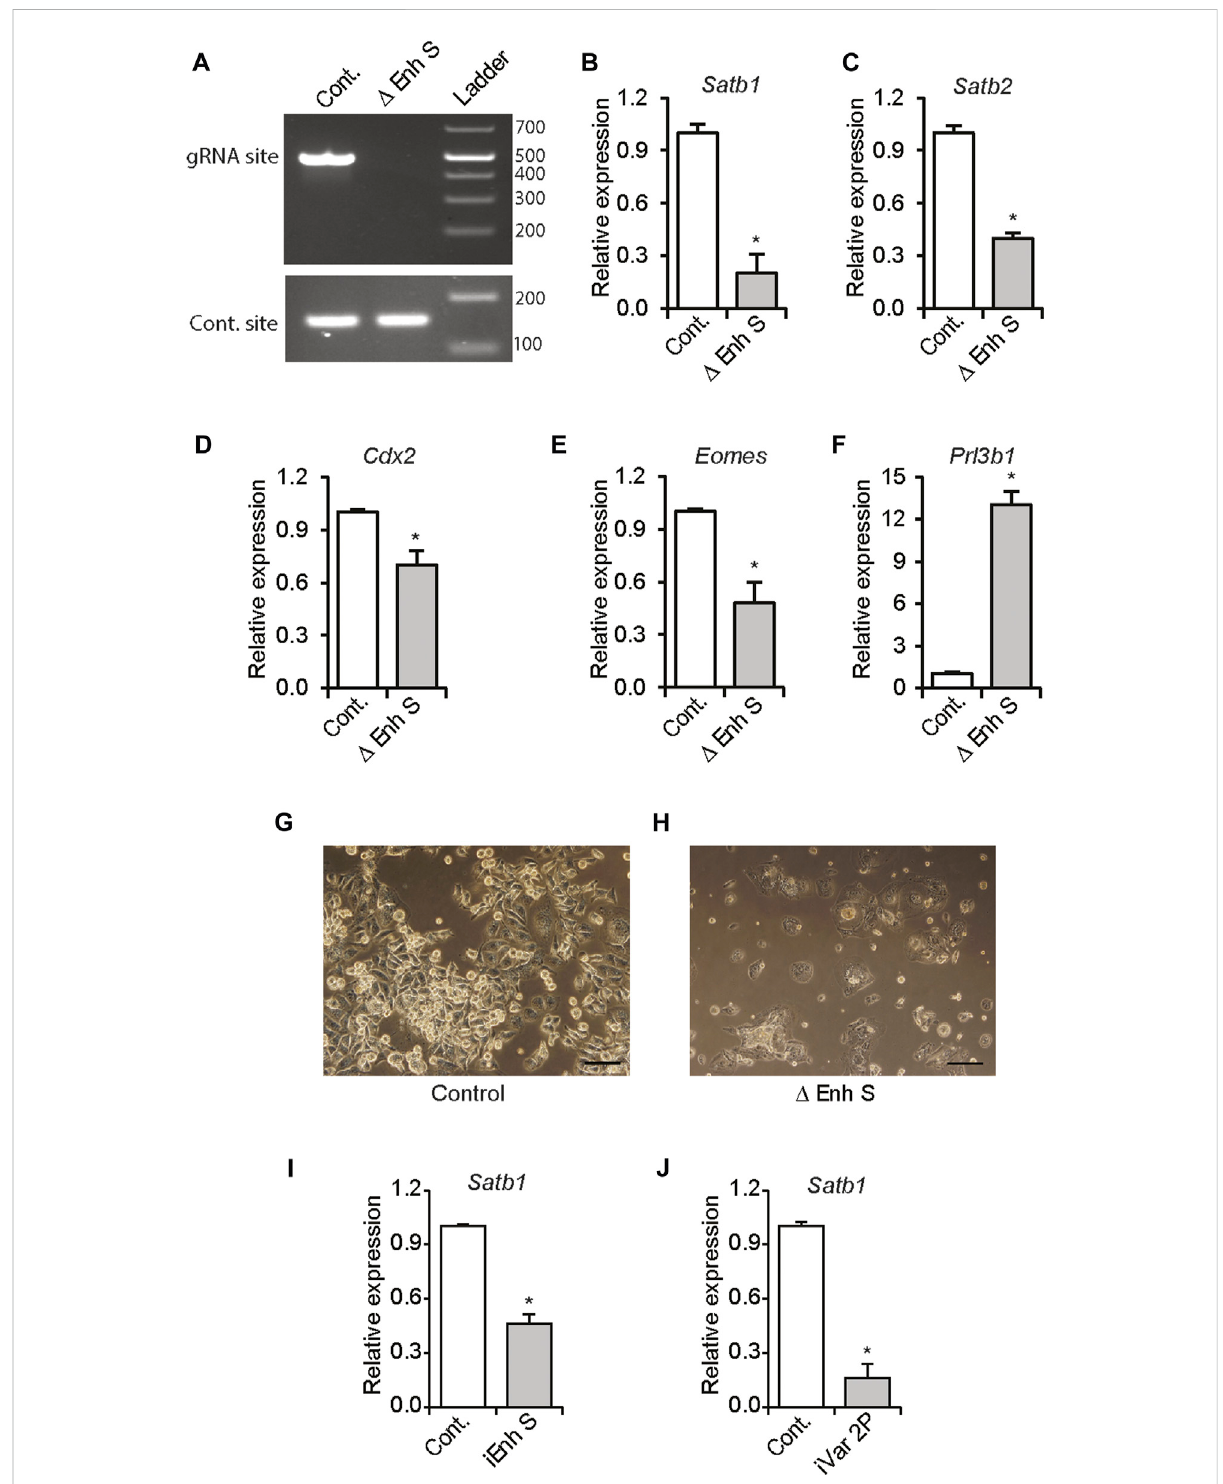
FIGURE 4 Enhancer S is required for Satb1 expression. Rcho1 rat trophoblast cells were transfected with Cas9 and control or targeted gRNA expression constructs. Stably transfected cells were selected and assessed for targeted deletion of the enhancer. Applying the CRISPR/Cas9 system resulted in the deletion of the gRNA targeted site in enhancer S ( Δ Enh S) (A) , decreased Satb1 and Satb2 expression (B,C) and caused differentiation of Rcho1 cells, characterized by deceased expression of Cdx2 and Eomes , and increased expression of Prl3b1 (D – H) . The requirement of enhancer S was further con fi rmed by transient transfection of dCas9-KRAB and the enhancer targeted gRNAs (iEnh S) (I) . Transfection of gRNAs targeted to the variant 2 promoter (iVar2P) was used as positive control (J) . RT-qPCR data are expressed as the means ± S.D. * p < 0.05 ( n =